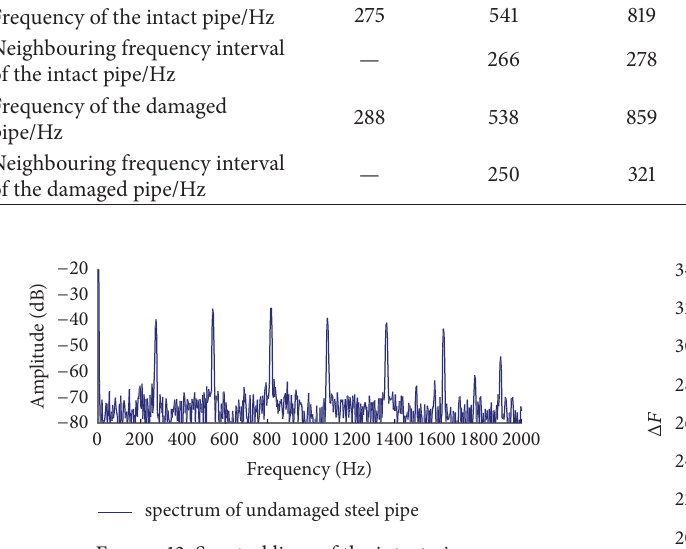
Figure 13: Spectral lines of the intact pipe.